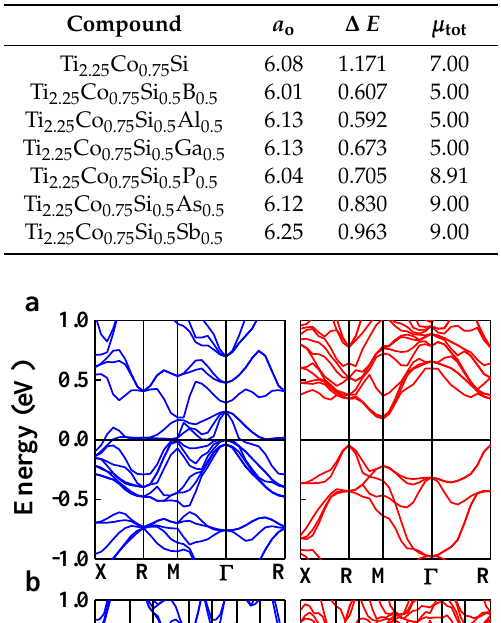
Table 1. The optimized equilibrium lattice parameter, a o (Å ); the energy difference △ E (eV) between anti-ferromagnetic (AFM) and ferromagnetic (FM) states; and the total magnetic moment μ tot ( μ B ) of the studied compounds.